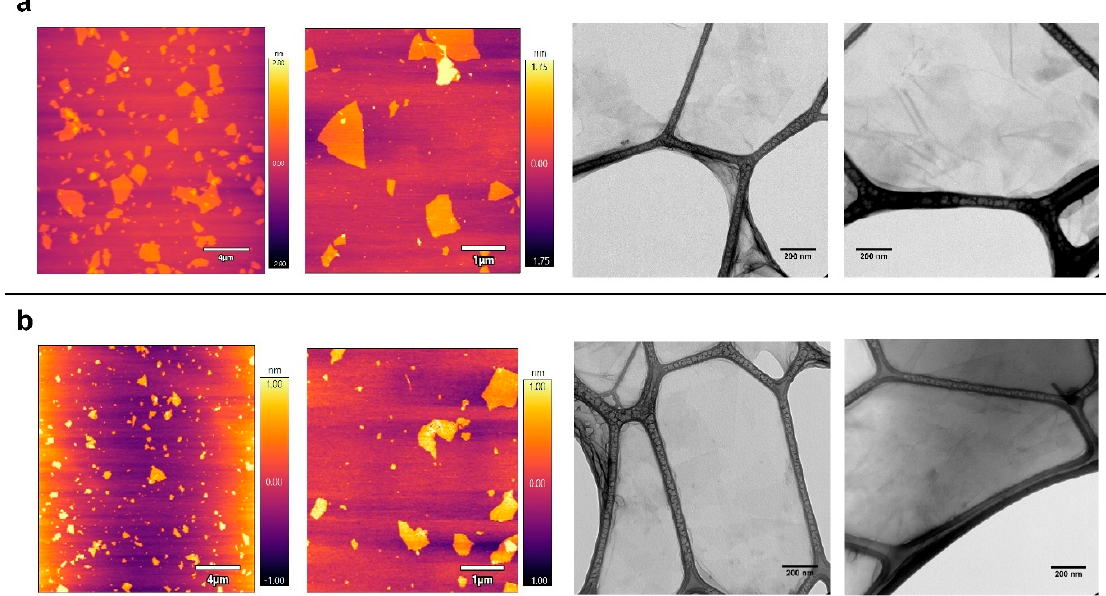
Figure 1. AFM and TEM analysis of graphene oxide (GO) ( a ) and graphene oxide nanocolloids (GOC) ( b ). Graphene suspensions with a final concentration of 20 mg L − 1 were deposited by drop casting on a mica surface and carbon-coated copper grids respectively.